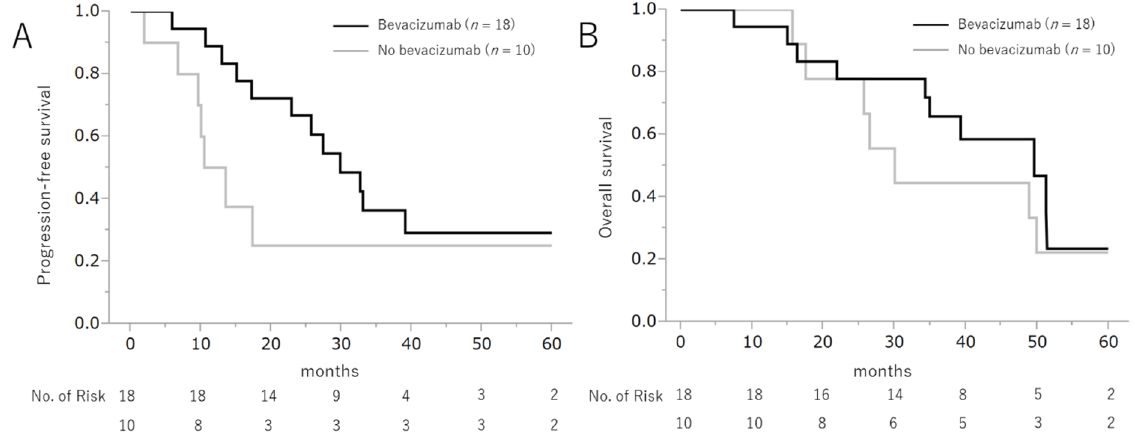
Figure 1. Progression-free survival and overall survival following the addition of bevacizumab to the chemotherapeutic regimen.